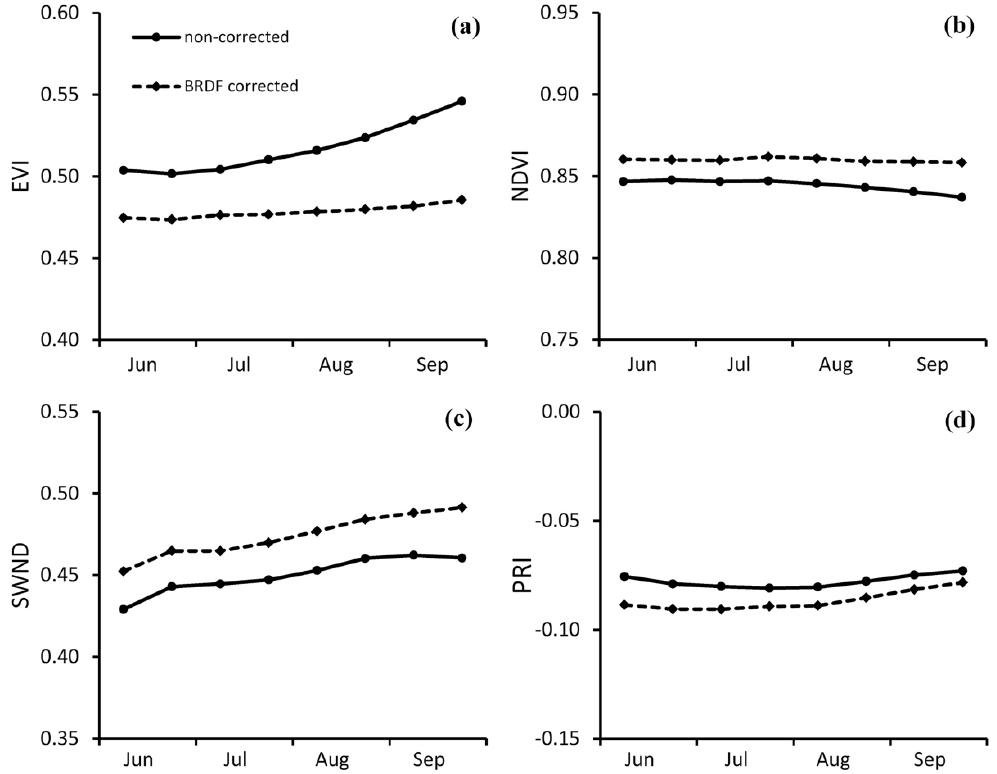
Figure 8. Monthly average profiles for the ( a ) enhanced vegetation index (EVI), ( b ) normalized difference vegetation index (NDVI), ( c ) shortwave infrared normalized difference (SWND), and ( d ) photochemical reflectance index (PRI), showing spectral variations before and after BRDF correction from the beginning (June) to the end (September) of the Amazonian dry season. Results refer to the 2000–2014 period ( n = 4500 pixels per date).